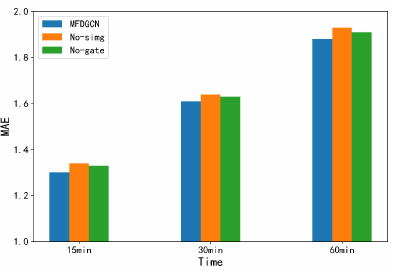
Figure 10. Comparison of MAE values of prediction results of MGSTCN, No-simg, and No-gate models at 15, 30, and 60 min on the PeMS_BAY data set.